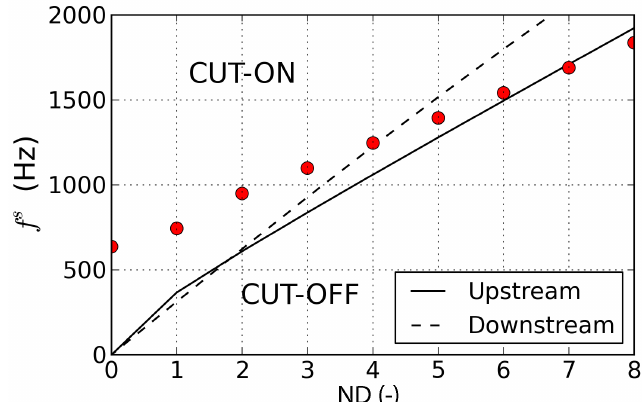
Figure 18. Mode 2 (red dots) acoustic conditions at OP-D and OP-E.